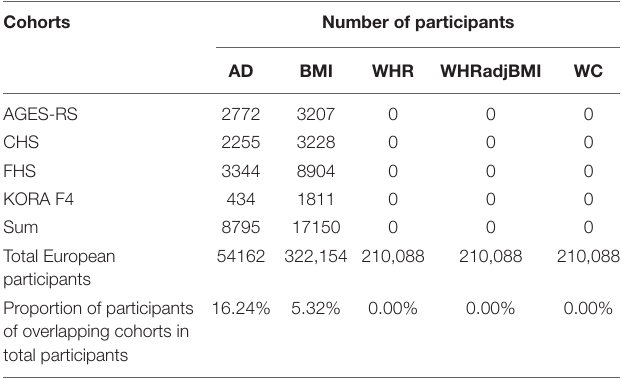
TABLE 1 | Possible sample overlap between the SNPs-each anthropometric trait and SNPs-Alzheimer’s disease datasets.